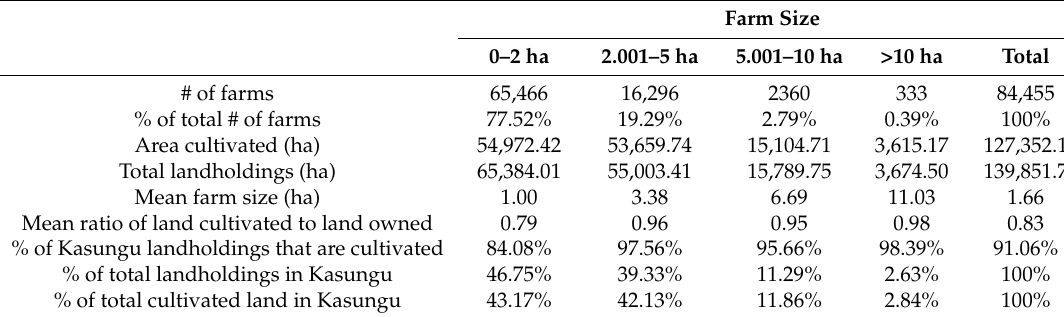
Table A1. Landholdings and area cultivated, by farm size in Kasungu district. Source: [27].